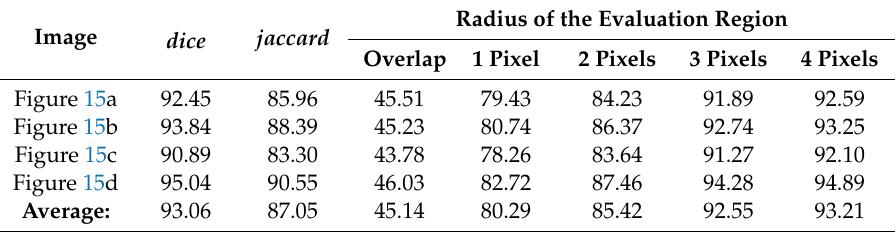
Table 4. Quantitative evaluation of riverway extraction results of each image (%)